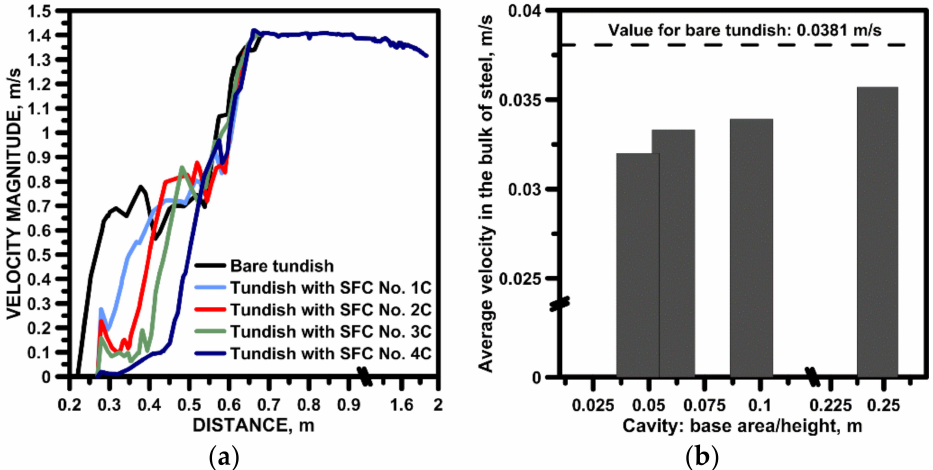
Figure 6. Liquid steel velocity magnitude in the tundish with modified SFC: ( a ) along vertical axis in the tundish pouring zone, ( b ) average velocity in the bulk of